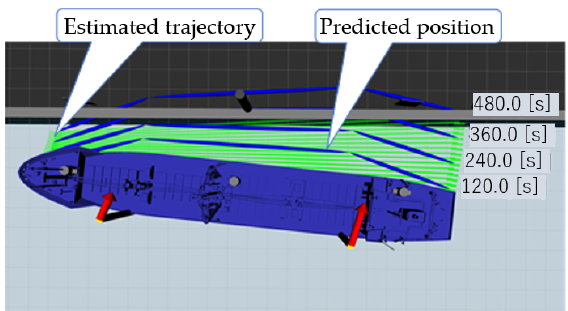
Figure 9. Visualization interface to render the predicted position and its trajectory.